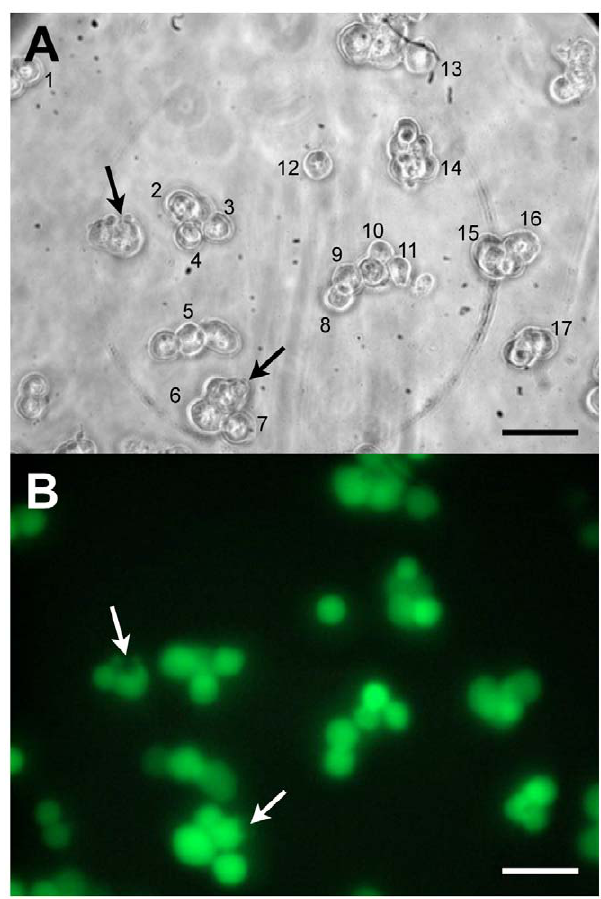
Figure 1. COS-7 cells suspended in the MicroCell chamber at 22 6 C. A) First image from a series of images initiated 21 s after cells had been exposed to hypotonic (157 mOsm/kg) TBS. The numbers indicate individually identified cells selected for analysis. The changes in their diameters were recorded until well after the cells had reached their maximal volume. Arrows point to two cells that show membrane damage in the form of a bleb of leaking cytosol. B) Fluorescence image of the same group of cells taken immediately after the last image of the bright light image series, about 5 min after A) was taken. Viable cells display green calcein AM fluorescence. Although the two damaged cells still display fluorescence, such cells were excluded from the analysis. Scale bar=50 m